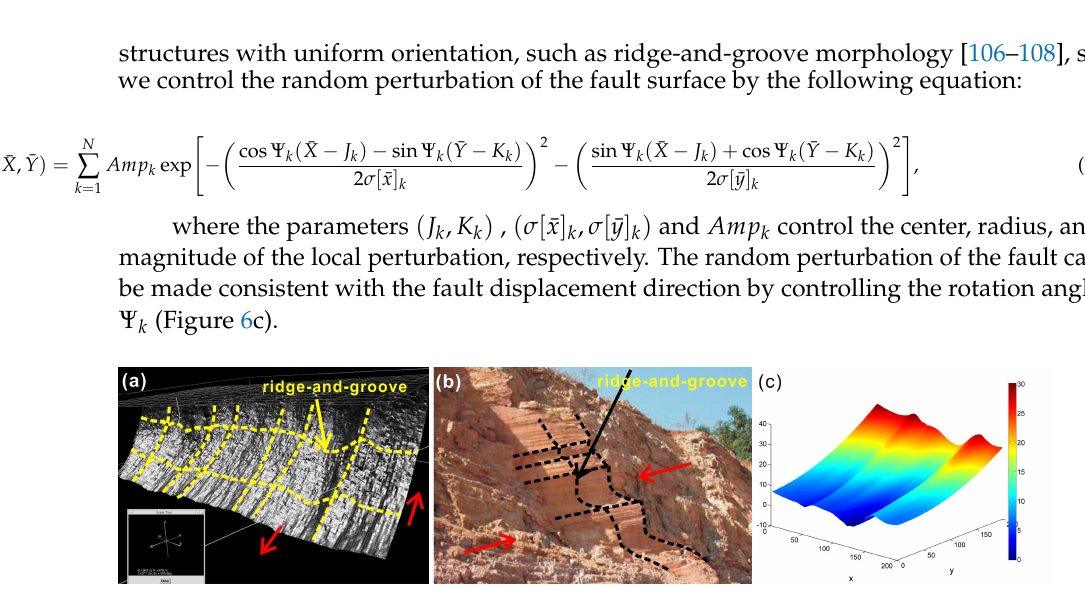
Figure 6. Demonstrations of ridge-and-groove morphology. ( a ) Normal fault surface modified after [108]. ( b ) Strike-slip fault surface modified after [109]. ( c ) Ridge-and-groove morphology generated in this paper. The red arrows represent the fault displacement direction. Reprinted with permission from [109]. 2022, John Wiley and